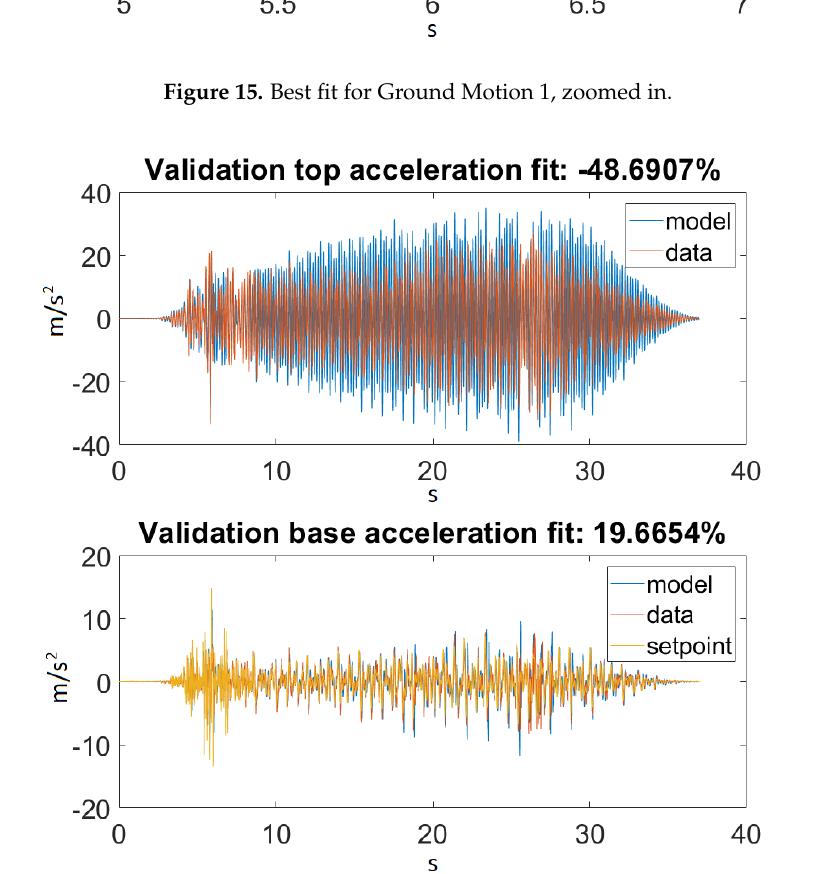
Figure 16. Best fit for Ground Motion